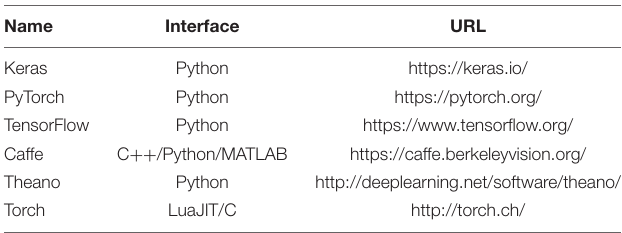
TABLE 2 | Some frequently used deep learning